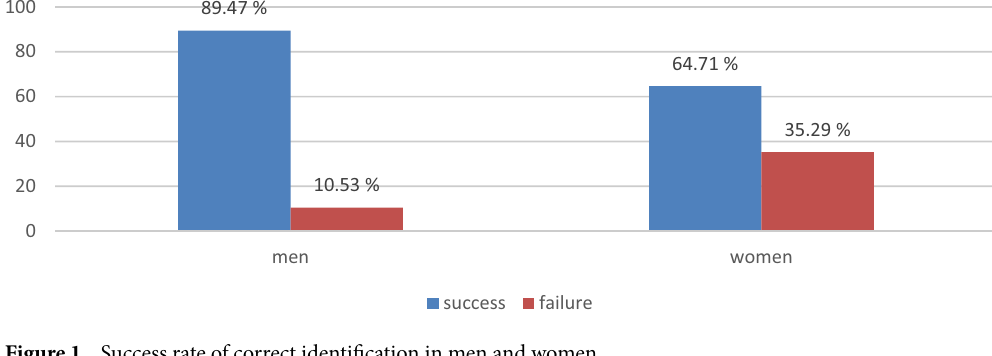
Figure 1. Success rate of correct identification in men and